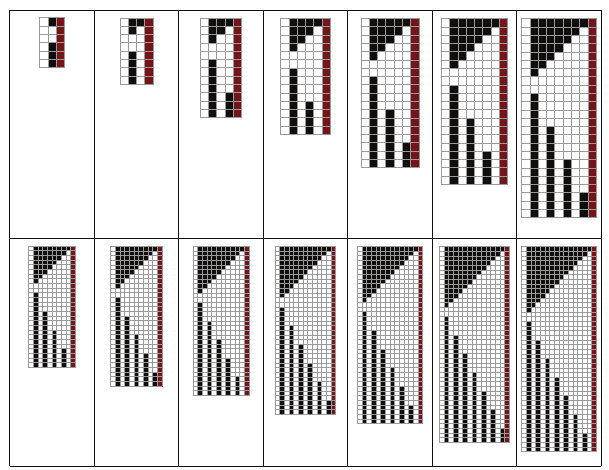
Figure 1: The figure shows a sequence of space-time diagrams corresponding to the TM in (2,2) space with number 346 (according to Wolfram’s enumeration scheme [12, 13] for (2,2) space) on inputs 1 up to